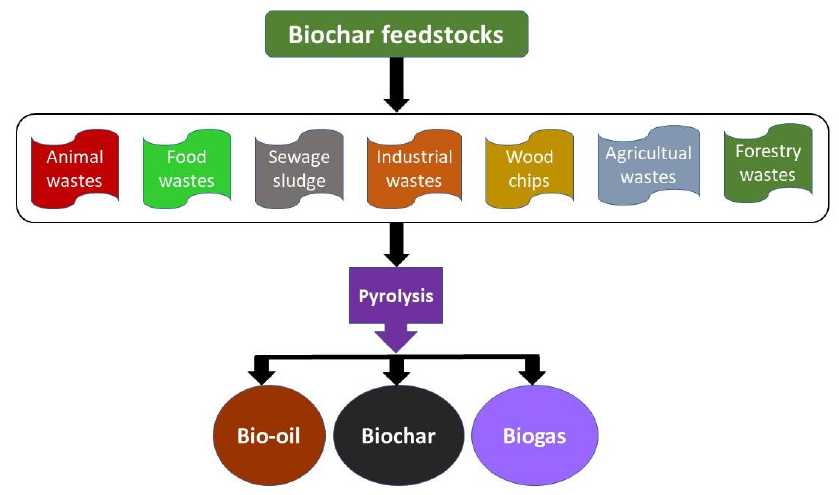
Figure 1. Schematic diagram showing biochar formation routes from different feedstocks.